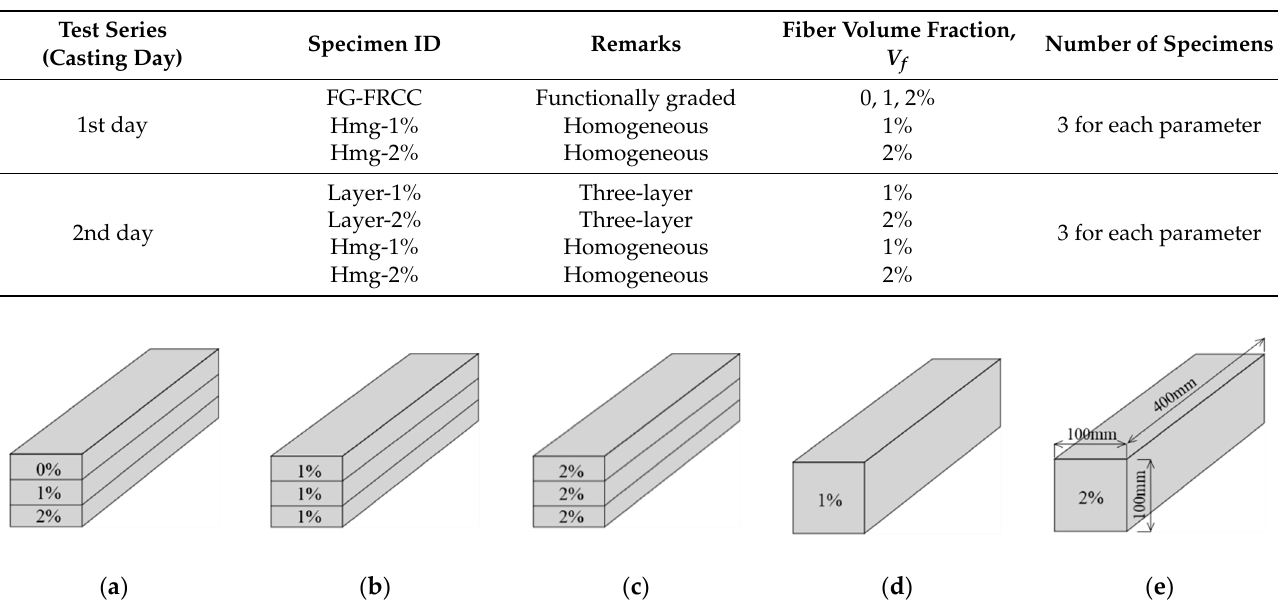
Figure 1. Specimens: ( a ) fiber-reinforced cementitious composite (FG-FRCC); ( b ) Layer-1%; ( c ) Layer-2%; ( d ) Hmg-1%; ( e ) Hmg-2%. Table 3. List of specimens.